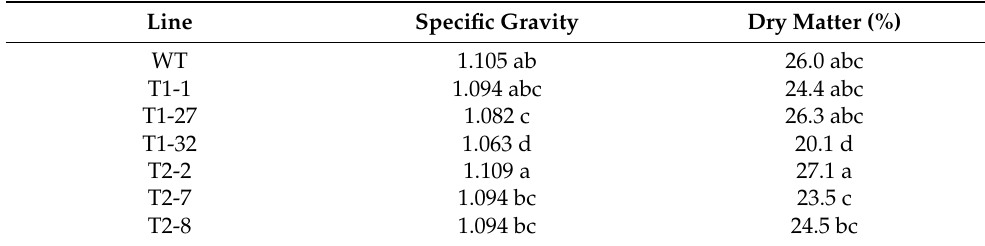
Table 1. Specific gravity and percent dry matter values in wild-type (WT, Yukon Gold strain TXYG79) and six different knockout events. n = tubers from three plants, except in case of event T1-1 tubers from only two plants were available; different lower-case letters for each value in the same column indicate a significant difference between plant types; p ≤ 0.05 (Student’s t -test). Line Specific Gravity Dry Matter (%) WT 1.105 ab 26.0 abc T1-1 1.094 abc 24.4 abc T1-27 1.082 c 26.3 abc T1-32 1.063 d 20.1 d T2-2 1.109 a T2-7 1.094 bc T2-8 1.094 bc 24.5 bc The perchloric acid method for starch analysis showed that the WT control tubers had an amylose content of 32.4%. Tubers from events T1-1 and T1-32 (gRNA1) and event T2-8 (gRNA2) had percentages of amylose content not significantly different from that of the WT tubers. T2-7 (gRNA2), the complete knockout event, showed an absence of amylose in the tubers. Event T1-27 (gRNA1) and event T2-2 (gRNA2) at 22.2% and 13.9% amylose, respectively, showed lower amylose content in the tubers although not enough to be considered complete knockout events when compared to the WT (Figure 5A). As explained in the Discussion, the chimeric nature of these edited events can account for such results.